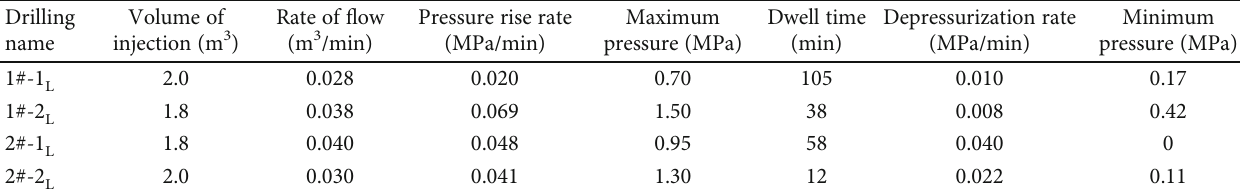
Table 3: Table of low-pressure injection